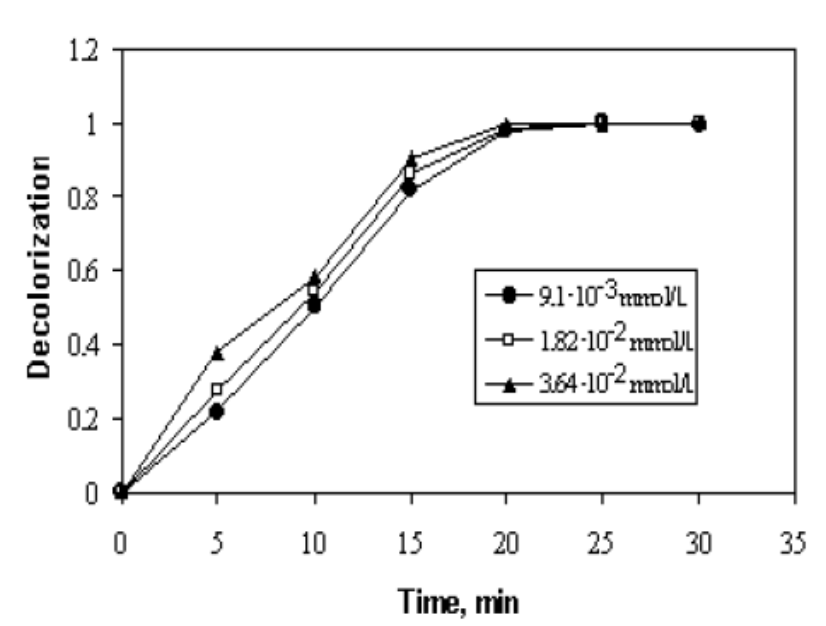
Fig. 17 Effect of Mn 2+ ions on AOP in neutral medium. Initial conditions: C dye =50 mg/L, [H 2 O 2 ]= 17.318 mM.